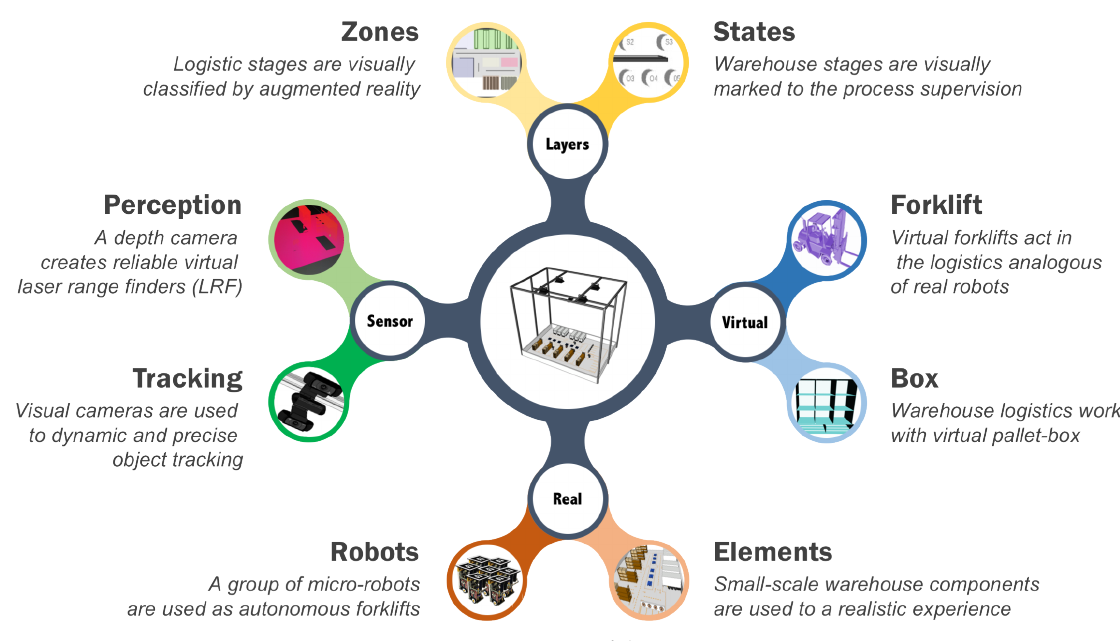
Figure 4. Overview of the